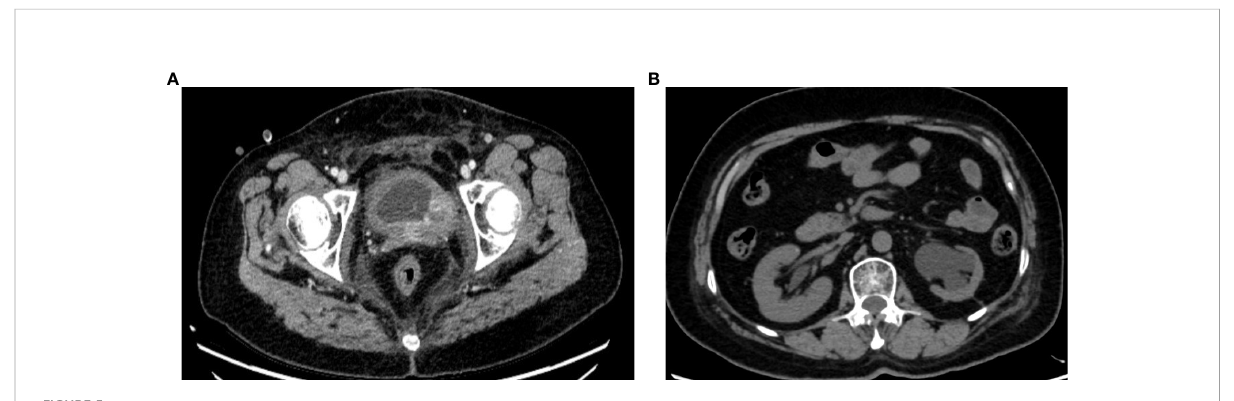
FIGURE 5 (A, B) Urinary tract computed tomography urography (October 24,